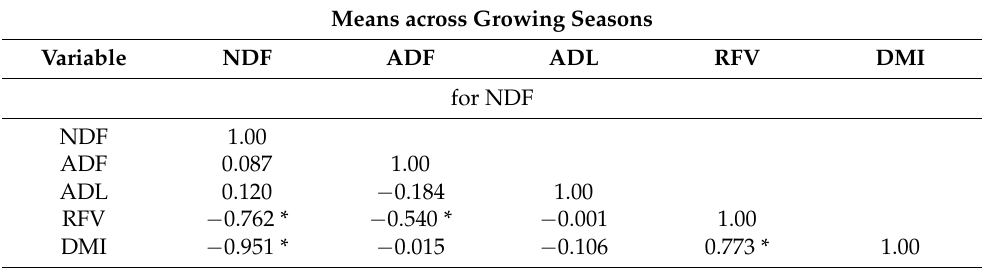
Table 9. Linear correlation coefficients between Festulolium braunii NDF and ADF content and other